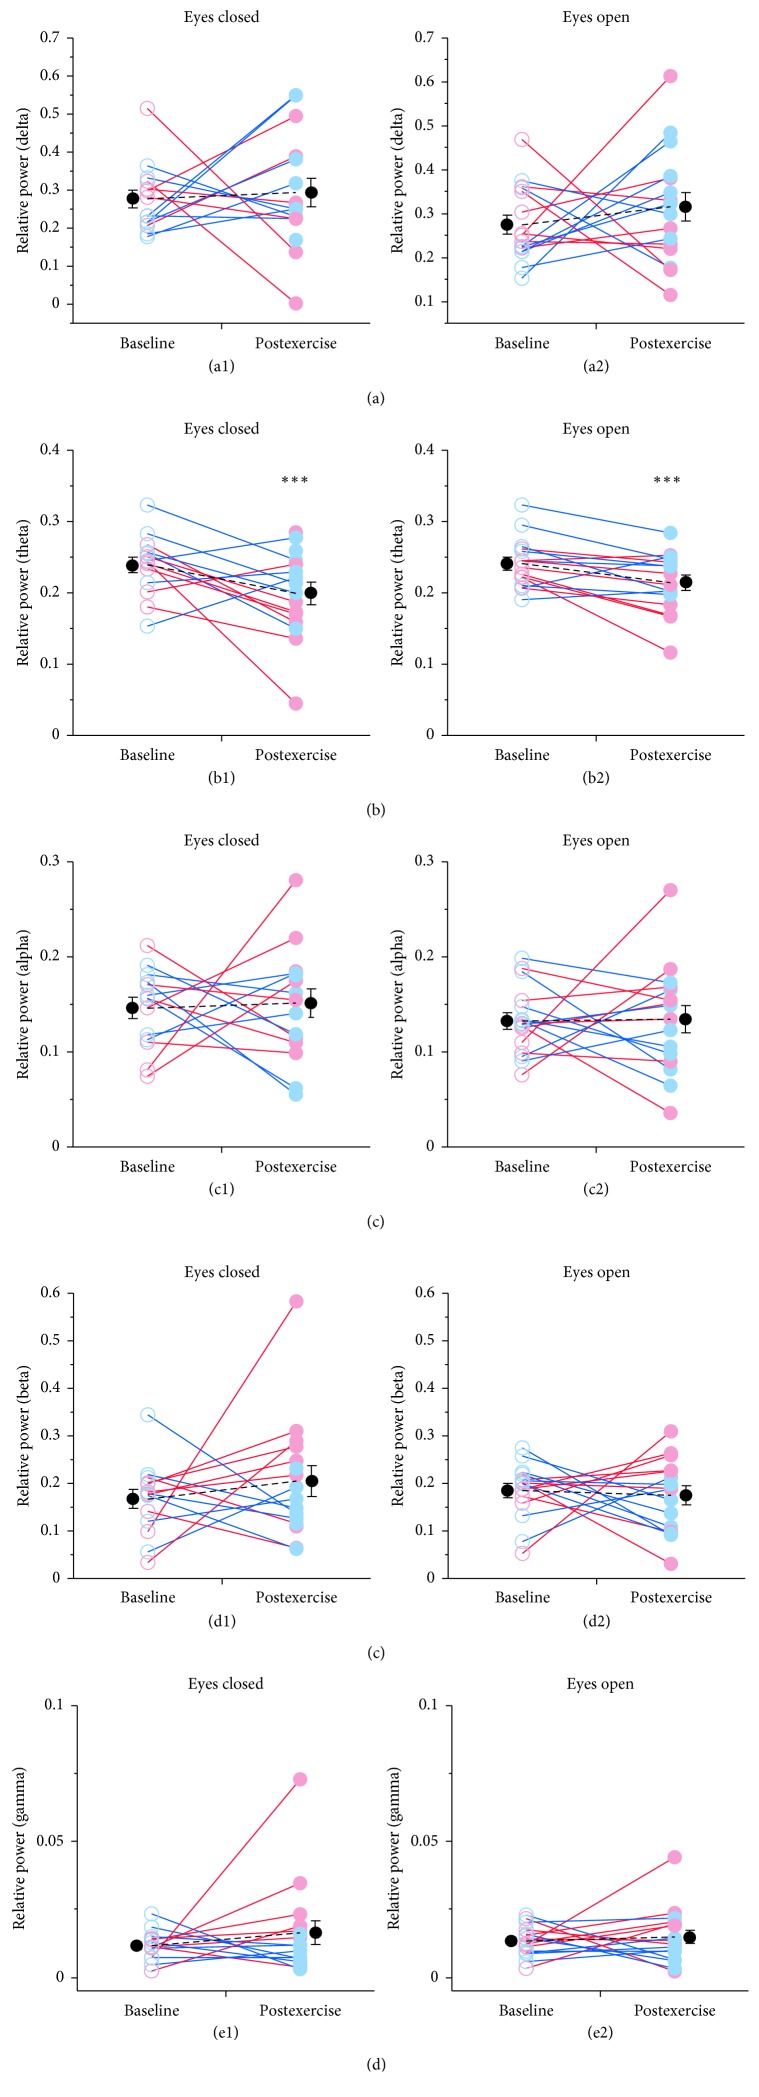
Effects of moderate exercise on qEEG relative spectral power. Spectral power was quantified for each subject during eyes closed (EC) (left; n = 14) and eyes open (EO) (right; n = 16) tasks. For each spectral band ((a) delta, (b) theta, (c) alpha, (d) beta, and (e) gamma), the mean relative power during each task is plotted during baseline (open circle) and after 1-mile run (closed circle). EEG was recorded from position Fp1 (international 10–20 montage placement system). EC data from two subjects contained too much artifact noise and were excluded from analysis. Plot conventions are as described in Figure 1.